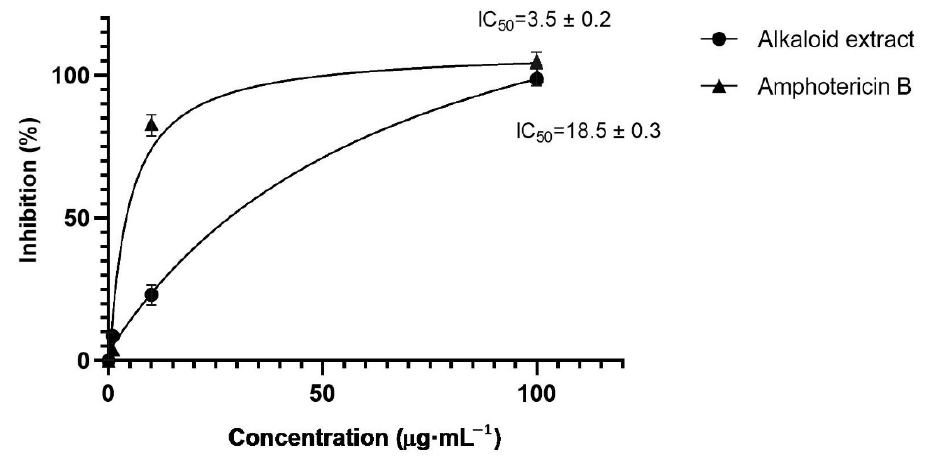
Figure 2. In vitro antileishmanial activity of the alkaloid extract from Clinanthus milagroanthus